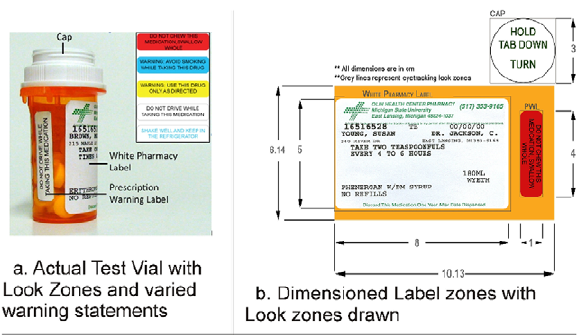
Figure 1. Actual vial used in this study depicting the three label zones of interest 1a - (1) cap, (2) standard white pharmacy label and (3) prescription warning label (PWL). (Inset: Five color contrasts of PWLs used in this study) 1b- Flattened, scaled drawing.